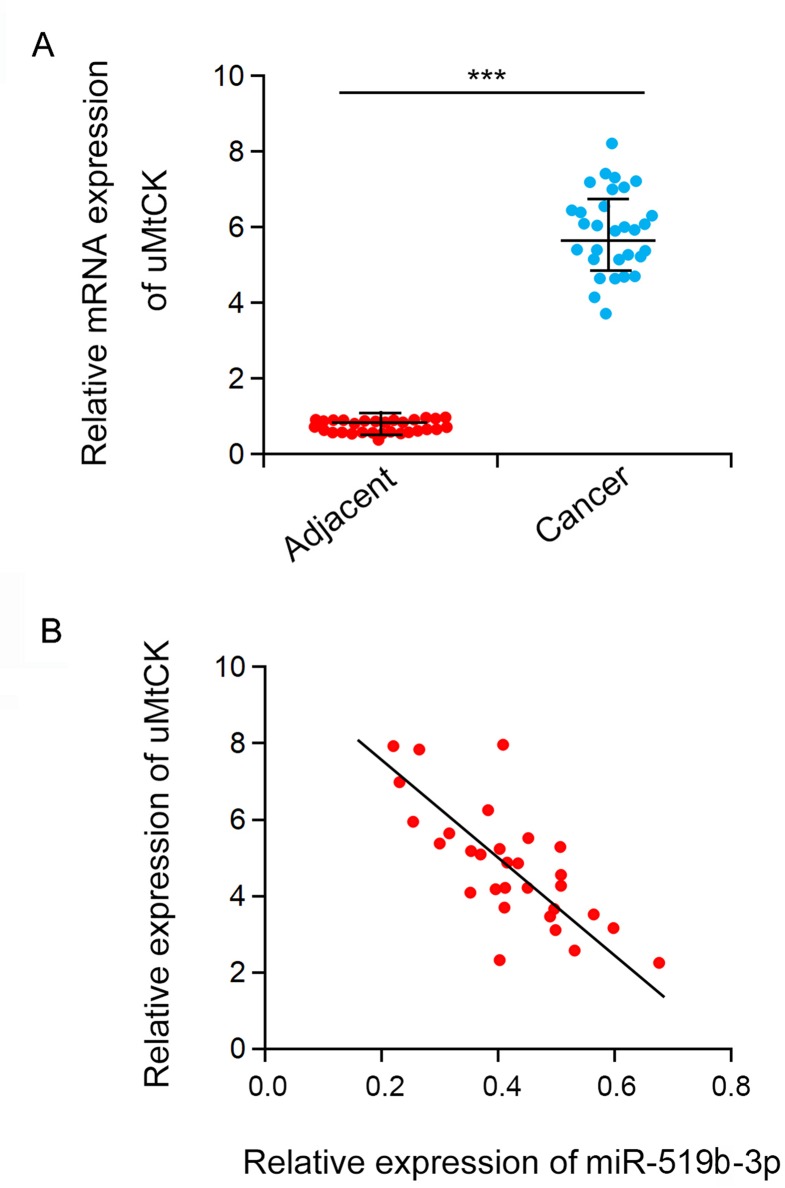
uMtCK was negatively correlated with miR-519b-3p expression in CRC tissues. (A) Relative mRNA expression of uMtCK in CRC tissues and surrounding non-cancerous tissues was detected by qRT-PCR. ***p < 0.001 vs. Adjacent. (B) Correlation between uMtCK mRNA and miR-519b-3p expression was detected by Spearman’s correlation assay. r = −0.846; ***p < 0.001.